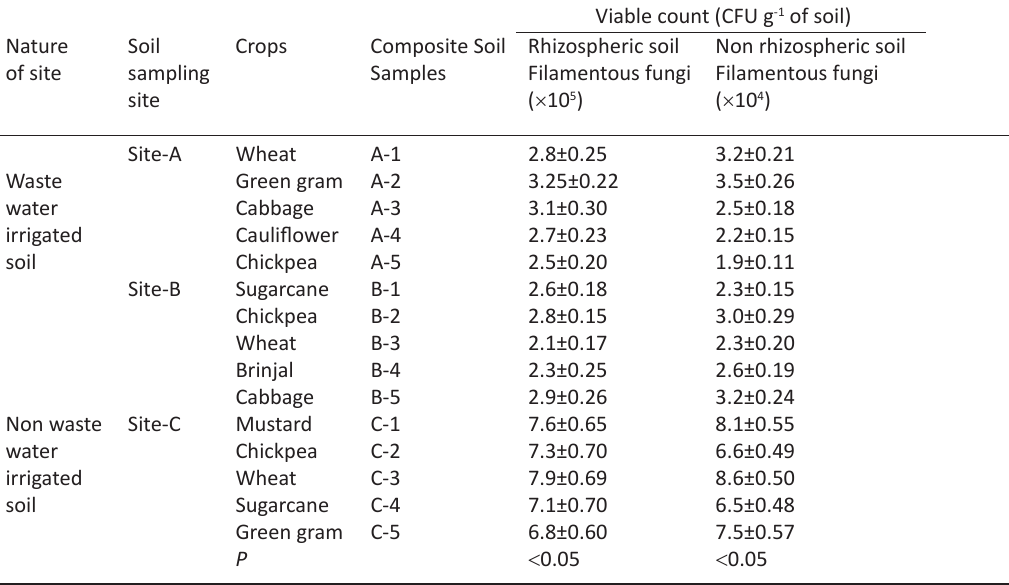
Table 2. Fungal viable counts in soil receiving long term application of wastewater in rhizosphere and bulk soils